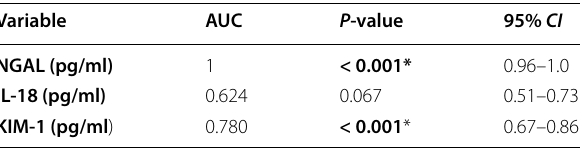
Table 4 ROC curve analysis of urinary biomarkers for